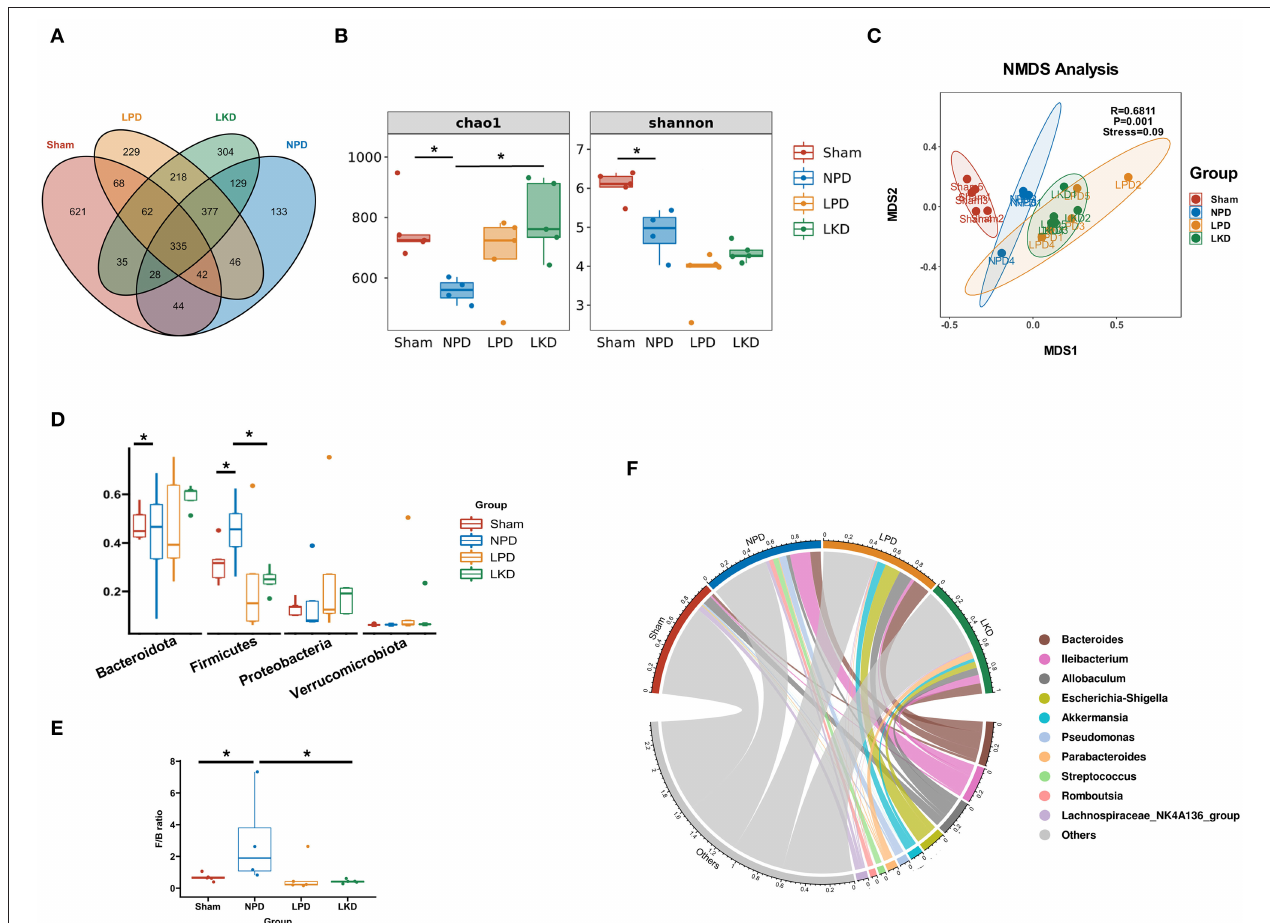
FIGURE 3 | Gut microbiome taxonomic features of four groups. (A) Venn plot indicating the number of OTUs of four groups. (B) α -Diversity: Chao1 and Shannon indexes (Mann-Whitney U -test). (C) β -Diversity analyzed by NMDS based on Bray-Curtis distances. (D) Comparison of the relative abundance of gut microbiota at the phylum level (Mann-Whitney U -test). (E) Comparison of the F/B ratio (Mann-Whitney U -test). (F) Chord plot showing the top 10 genera and their contribution to each group. * P < 0.05.